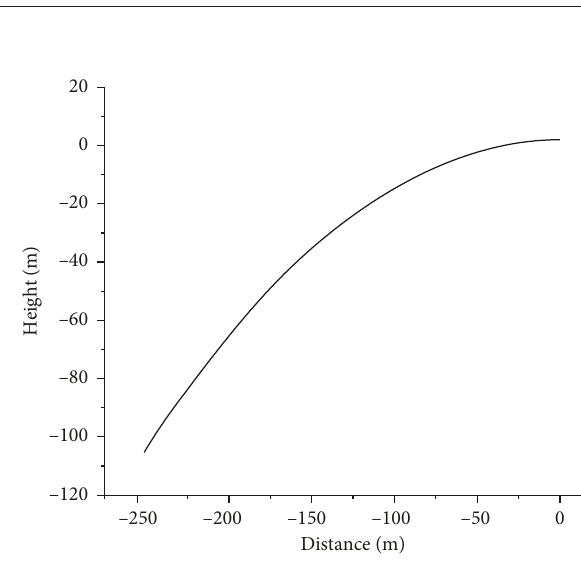
Figure 9: Half-span arch axis fitted by the cubic spline curve.